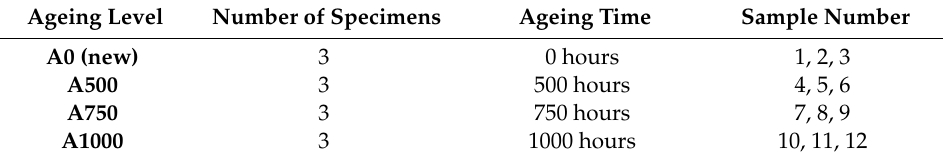
Table 1. Ageing levels and tested connectors. This table is valid for connectors J-line and S-line. Ageing Level Number of Specimens Ageing Time Sample Number